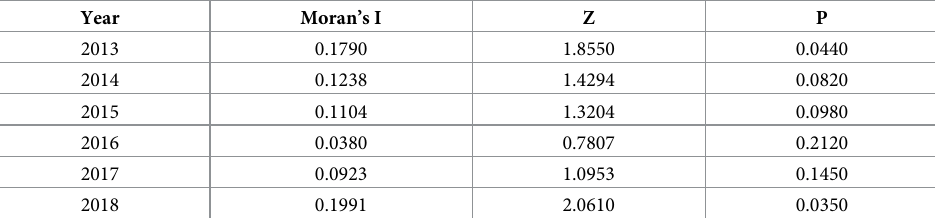
Table 3. Global Moran index of TE from 2013 to 2018.